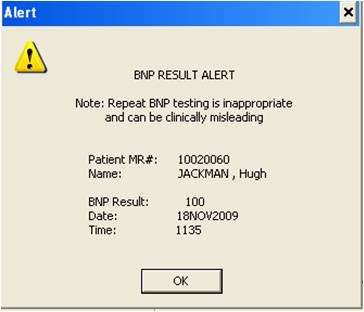
Screenshot of alert providing recent BNP result information.